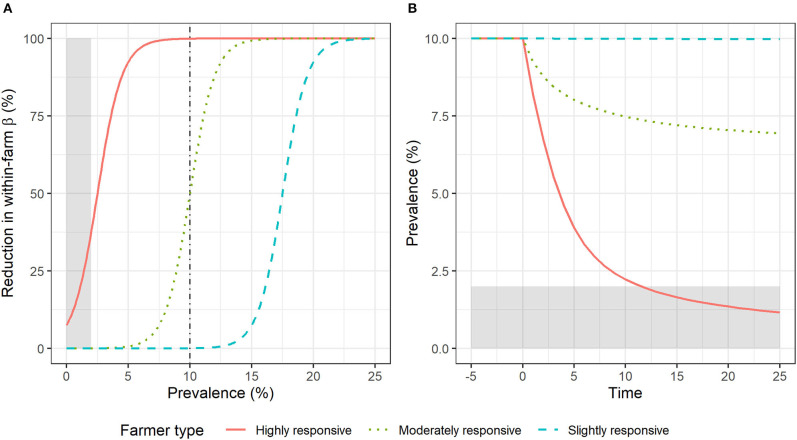
Effect of farmer type on disease prevalence following a common starting prevalence and a hypothetical awareness-raising event (at time zero). (A) Control effort applied (percentage reduction in transmission rate—β—within the farm in relation to the initial β in endemic equilibrium) as a function of disease prevalence for three different farmer types. The vertical dash-dotted line indicates initial prevalence. (B) Disease prevalence over time within the three farms. In both panels, the gray shaded area indicates the target prevalence level from society's perspective (<2%).